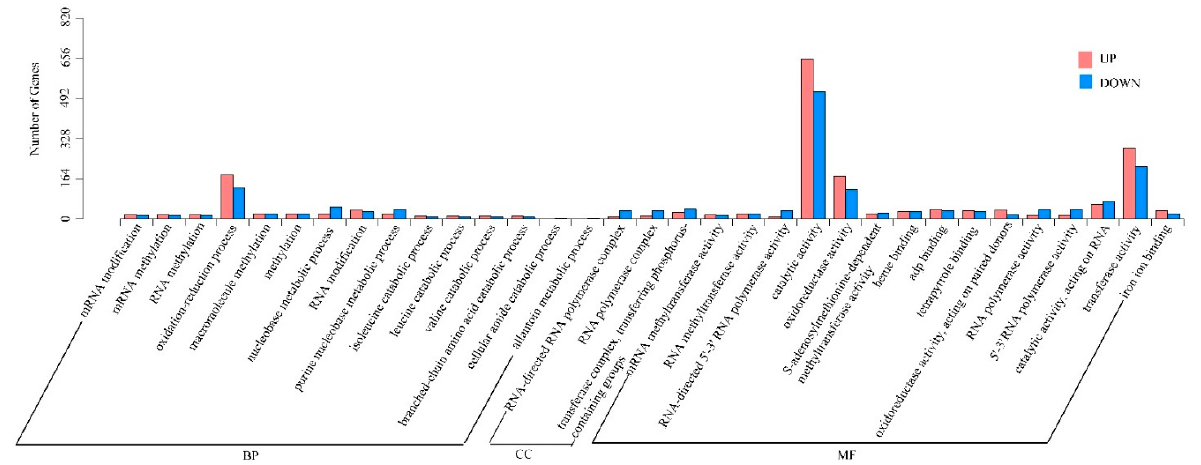
Figure 3. GO classification of upregulated and downregulated DEGs identified between ‘Changying’ and ‘Huiyuan’ fruits. BP: biological process; CC: cellular component; MF: molecular function.